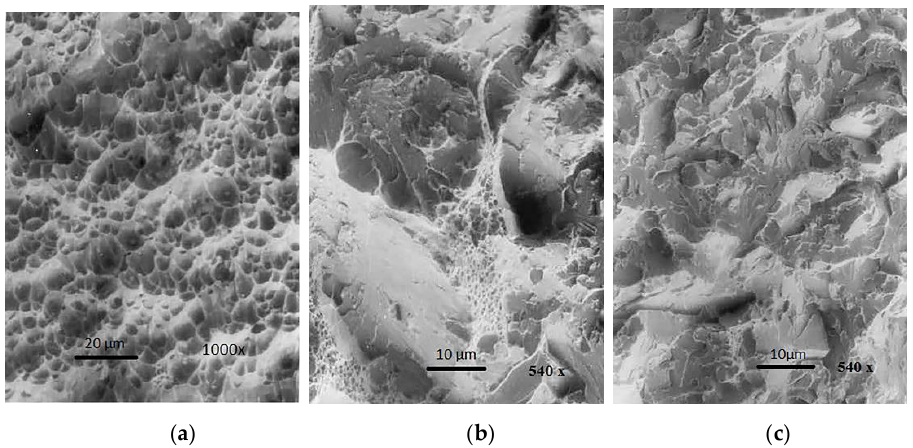
Figure 7. SEM fracture surface view of testing of toughness of WM formed by using electrode No.1.1: ( a ) ( t = +20 °C), ductile fracture; ( b ) ( t = −40 °C), brittle fracture of transcrystalline and intercrystalline character in the middle of WM; ( c ) ( t = −60 °C), brittle fracture of transcrystalline and intercrystalline character in the middle of WM.